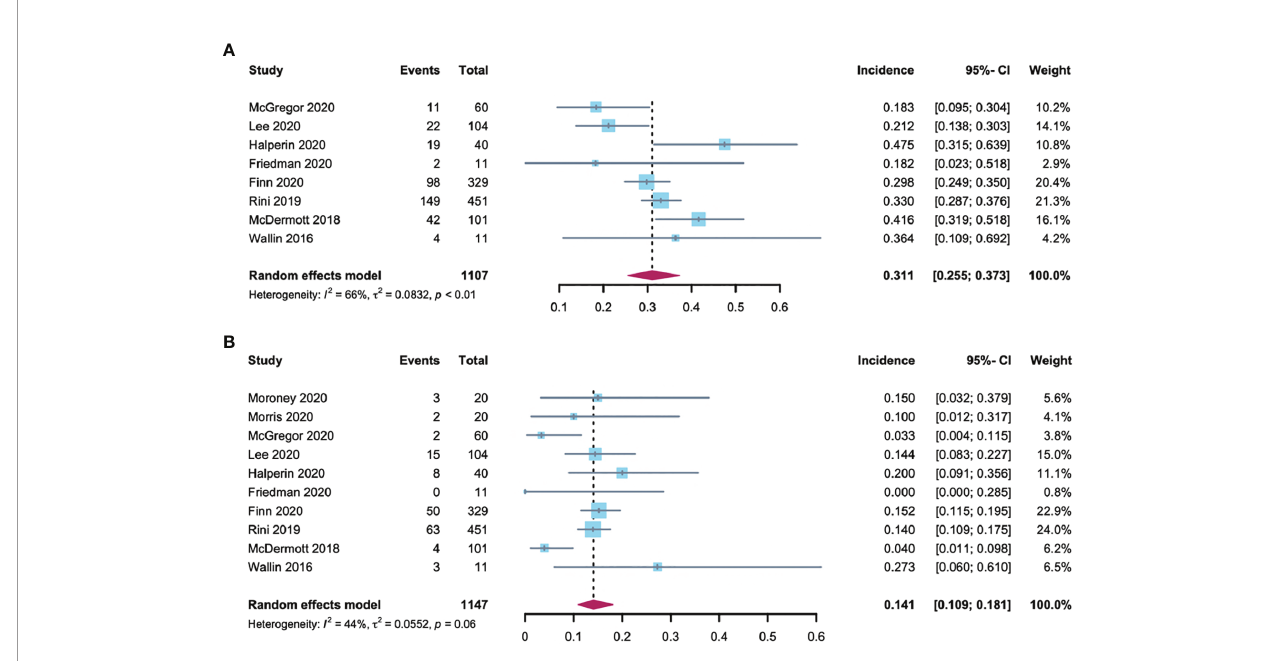
FIGURE 2 | Forest plot of hypertensionincidence in cancer patients treatedwith (A, B) . (A) incidences of all-grade hypertension; (B) incidences of high-grade